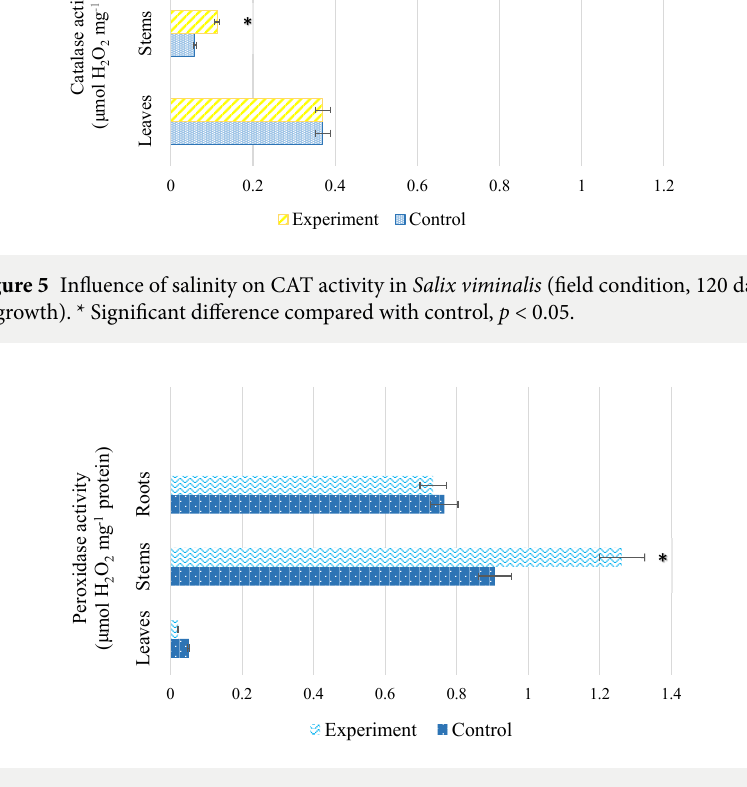
Figure 6 Influence of salinity on POD activity in Salix viminalis (field condition, 120 days of growth). * Significant difference compared with control, p <